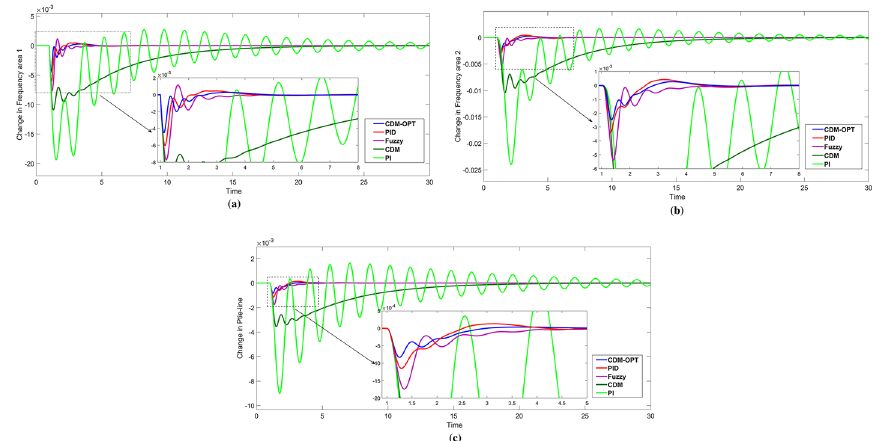
Fig. 5 Case 2 signals: a Frequency in area 1. b Frequency in area 2. c Tie-line between